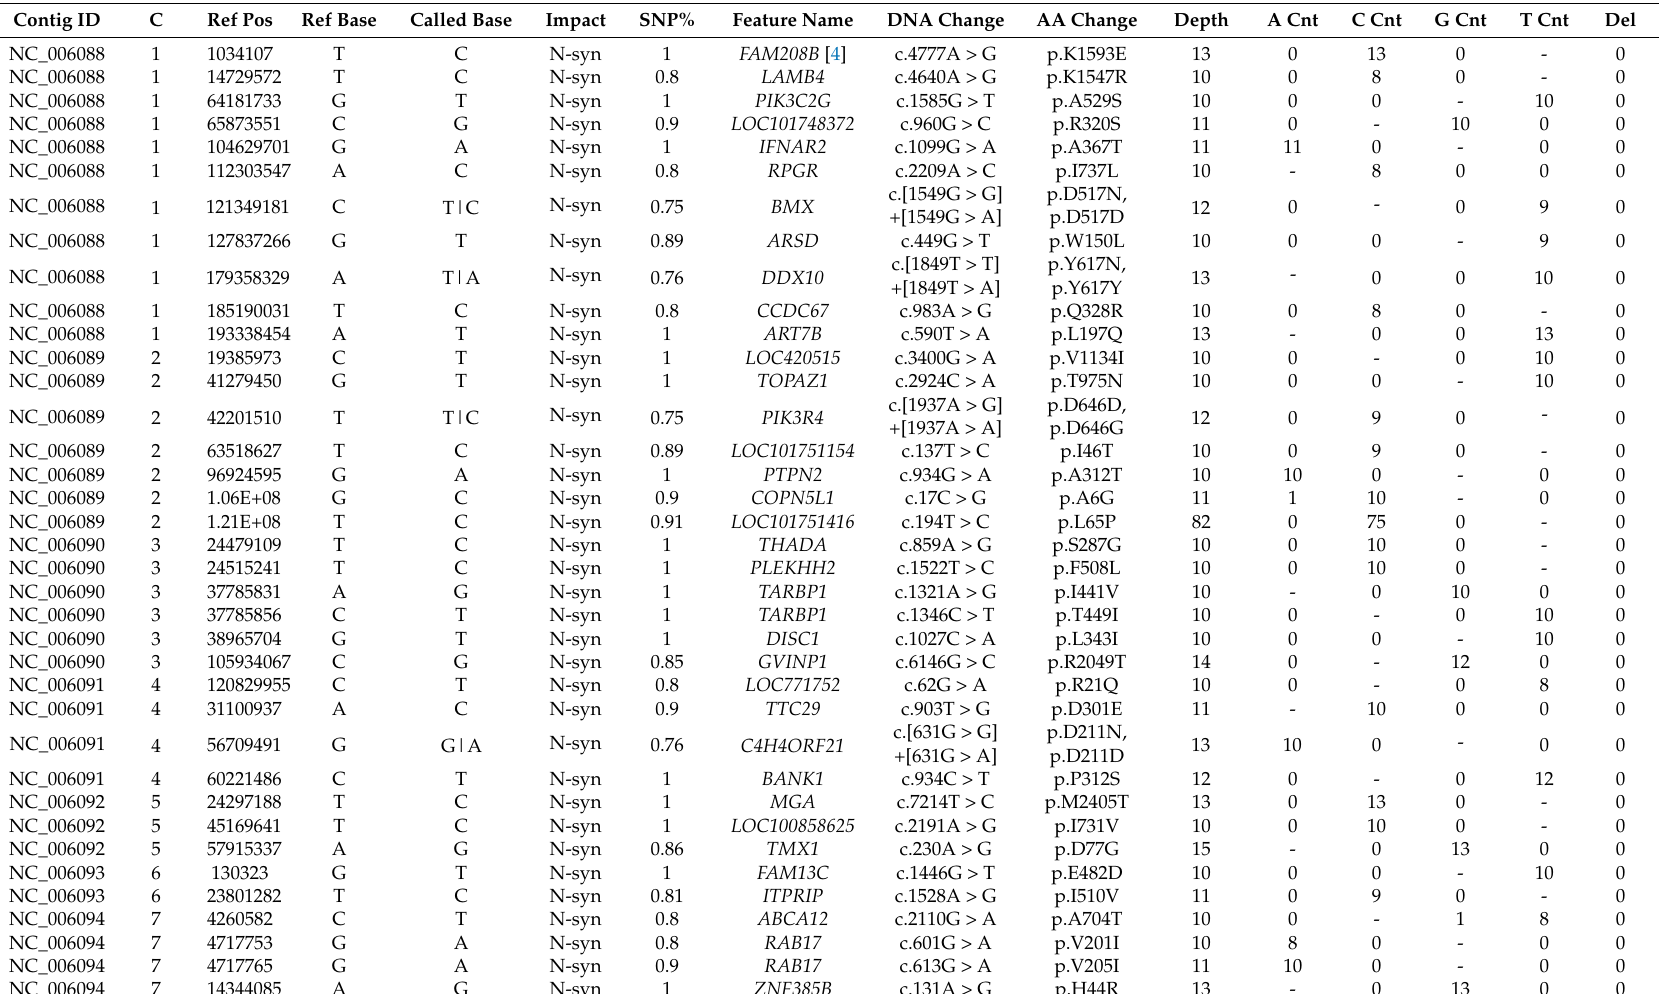
Table 3. The 63 reliable marker SNPs that induced amino acid changes showing ≥ 10 read